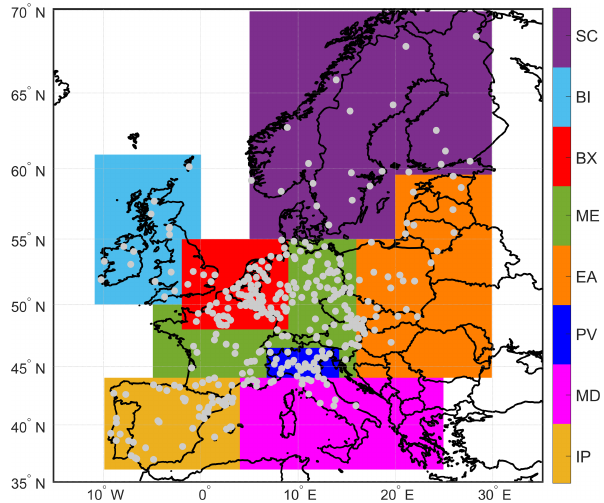
Figure 1. The European model domain and its subregions: the Iberian Peninsula (IP), the Mediterranean (MD), Po Valley (PV), eastern Europe (EA), mid-Europe (ME), Benelux (BX), the British Isles (BI) and Scandinavia (SC). Grey dots indicate the rural back- ground European Air Quality Database v7 (AirBase) stations of the hourly ozone